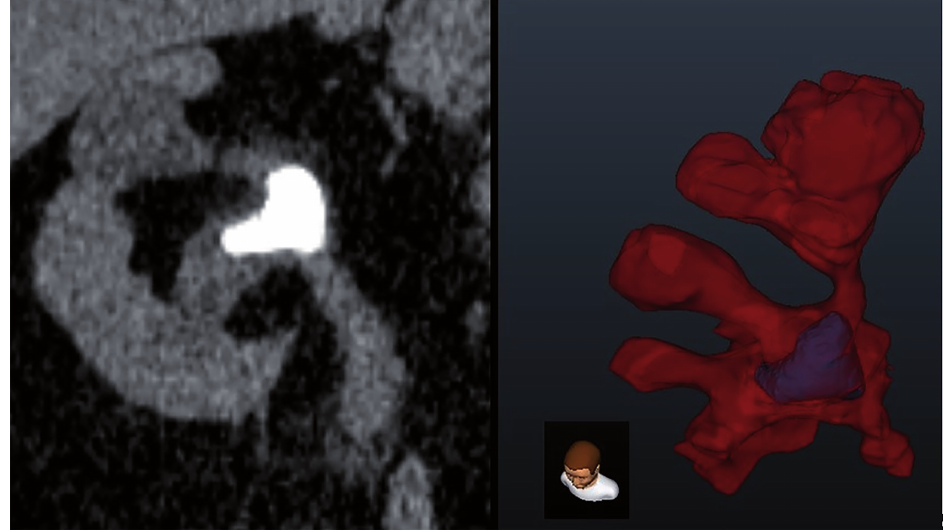
Figure 1 - NCCT and 3D volume segmentation images of pelvicalyceal system and